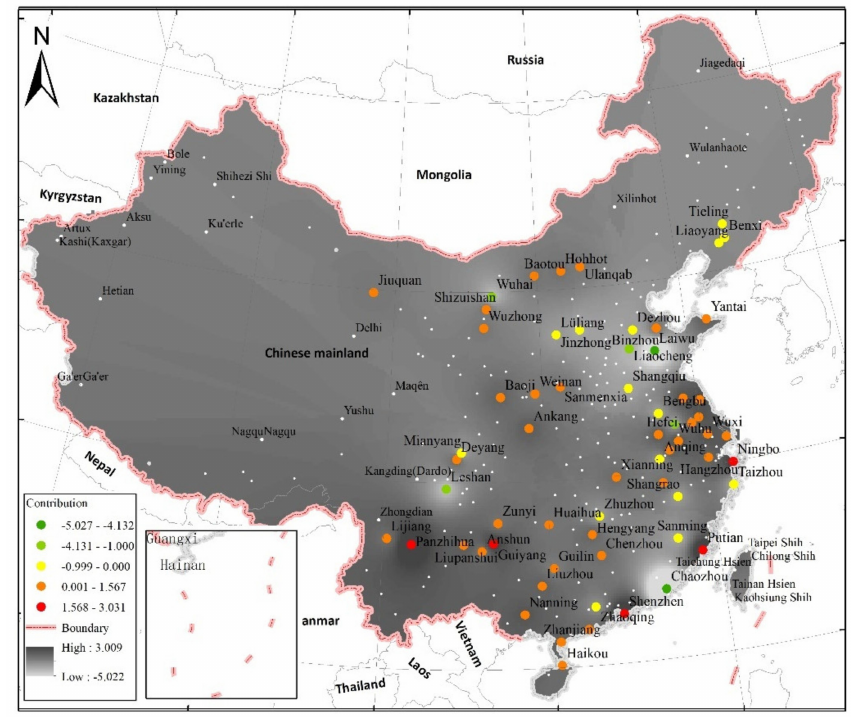
Figure A8. Contribution from the indicator IncomeMD (annual average labor income of downtown) to land-use intensity revealed in the city-based assessment.